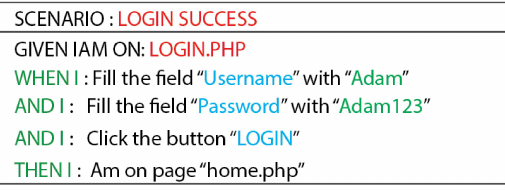
Fig. 7 Example of a BDD